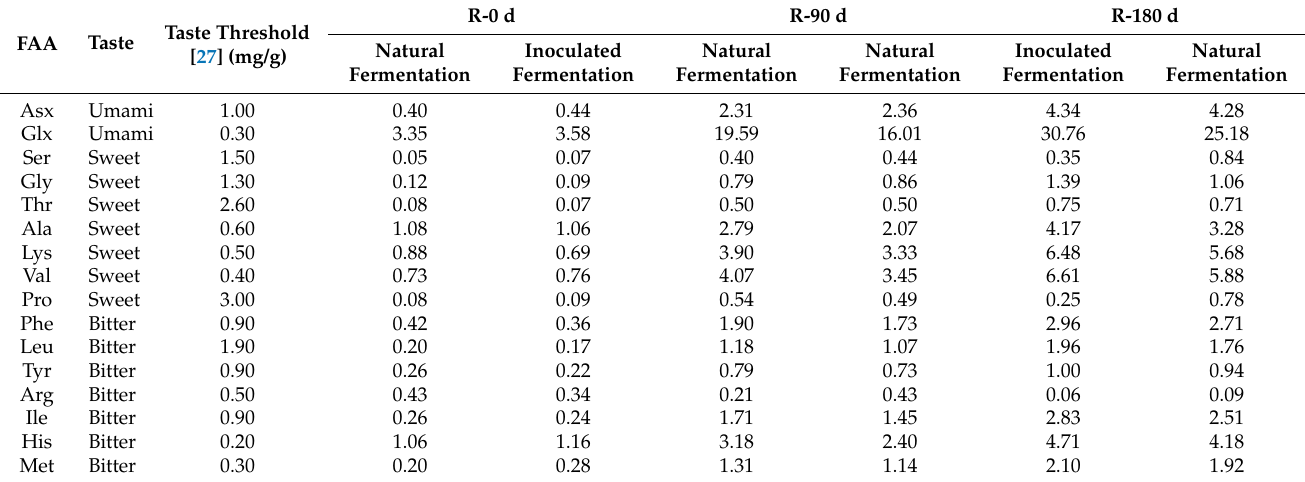
Table 4. TAV of free amino acids in natural and inoculated fermented